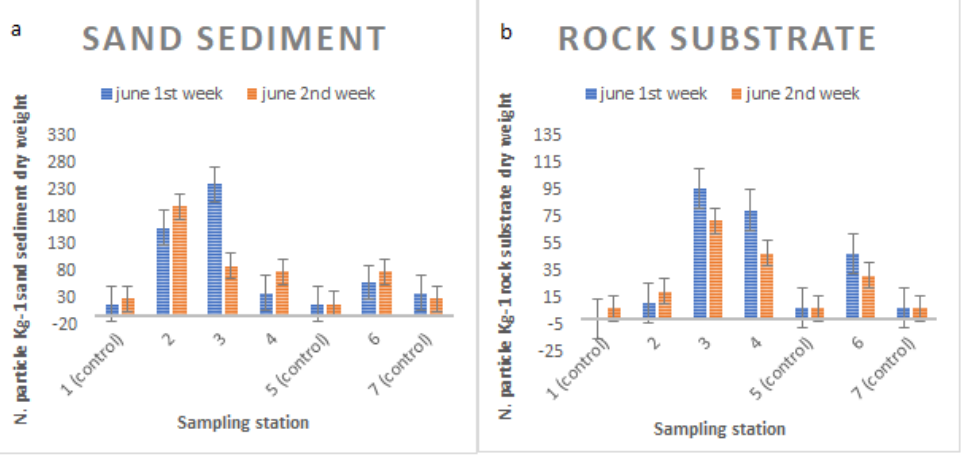
Figure 3. ( a ) sand sediment and ( b ) rock